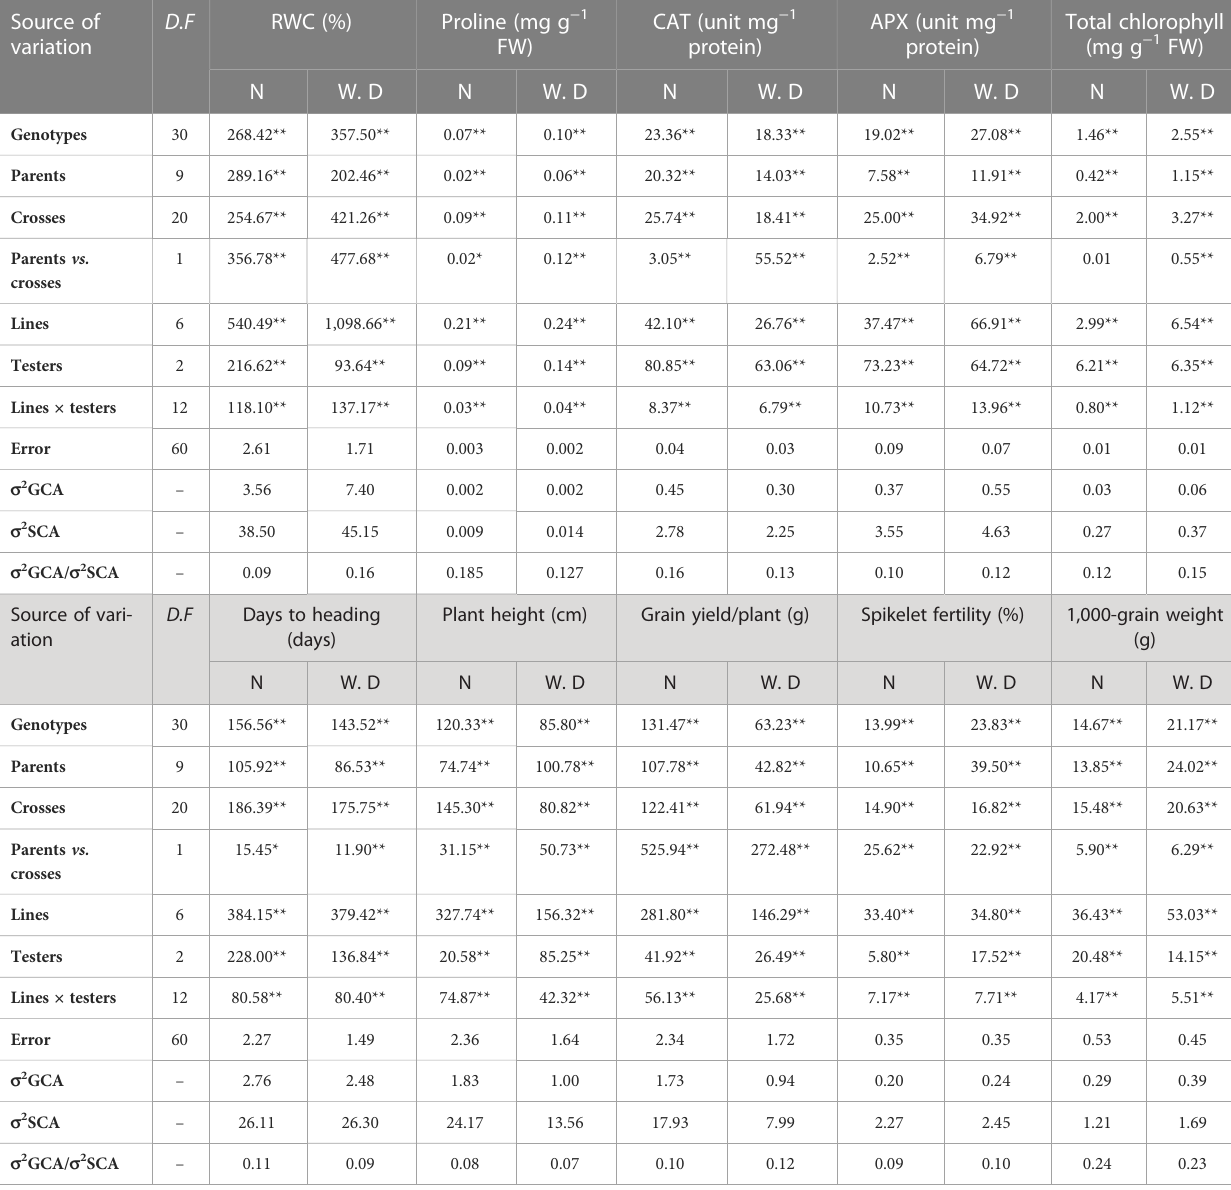
TABLE 2 Mean square estimates of ordinary, line × tester, and combining ability analyses for physiological, biochemical, and yield-related (and its components) traits under normal watering and water de fi cit conditions. Source of